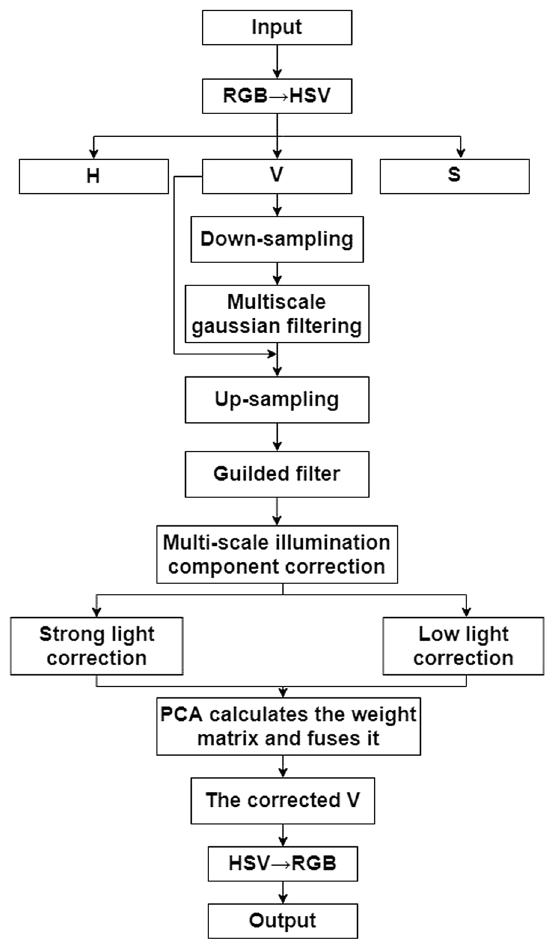
Figure 2: Fast adaptive image enhancement algorithm fl ow based on PCA